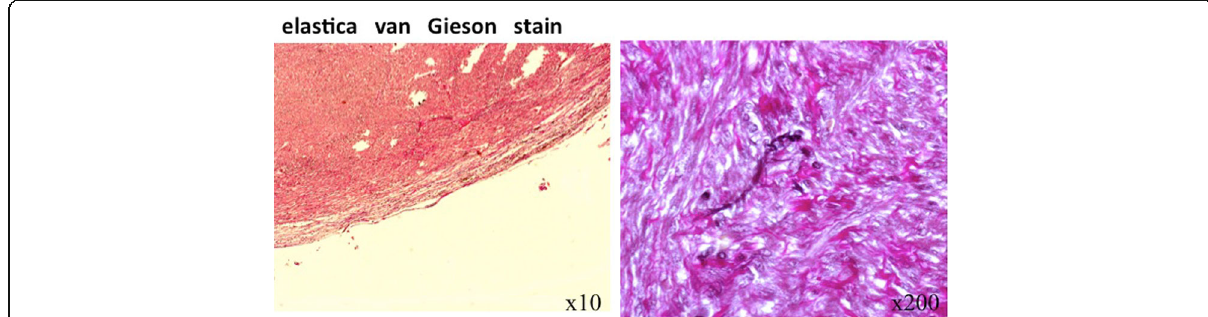
Fig. 7 Elastica van Gieson stain. Interrupted elastic fiber of the IVC was shown, although there was continuity of the elastic fiber in the outer layer of this tumor as determined by elastica van Gieson staining. IVC inferior vena